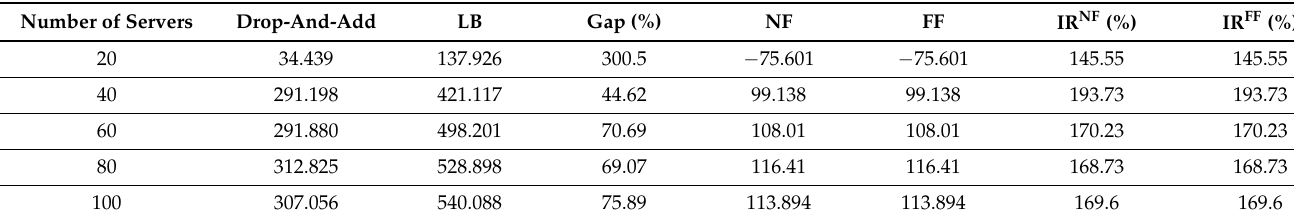
Figure 7. Objective value by the number of servers. Table 8. Comparison of solution qualities under different number of